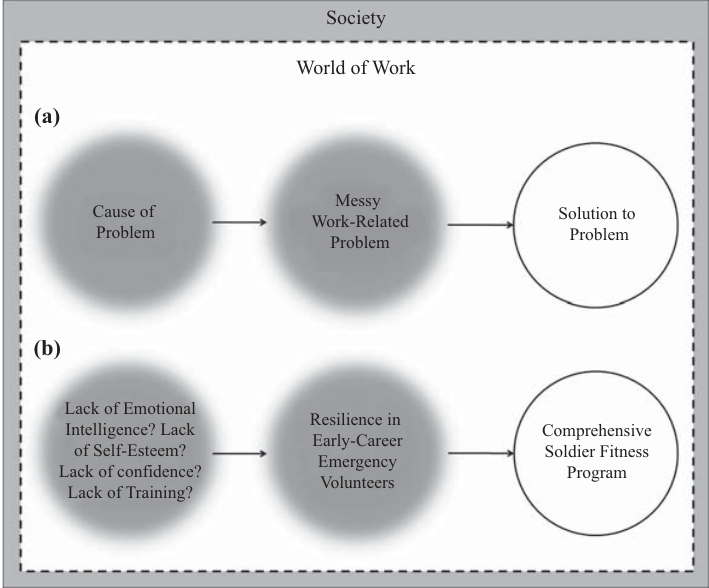
Figure 2. Conceptual model